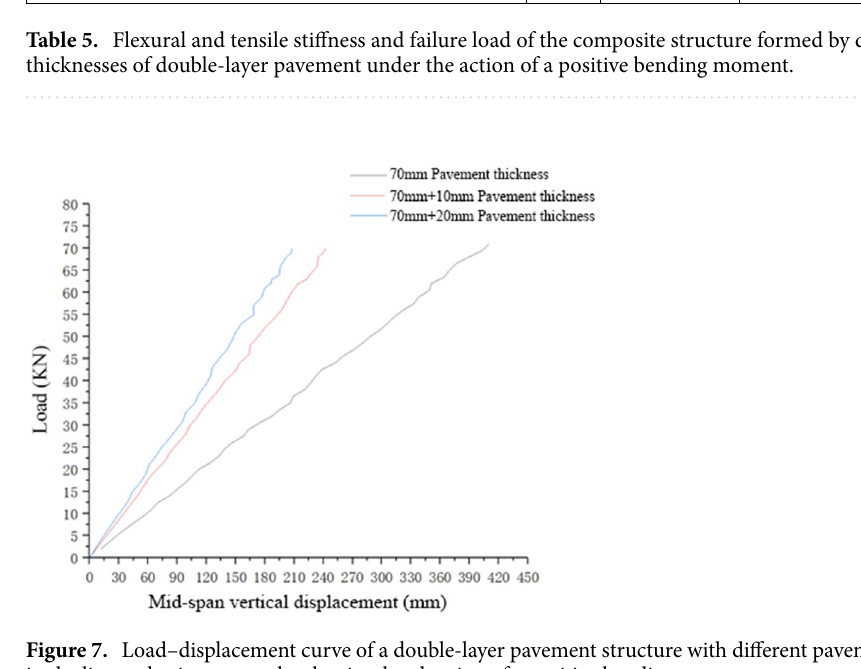
Figure 7. Load–displacement curve of a double-layer pavement structure with different pavement thicknesses in the linear elastic stage under the simulated action of a positive bending